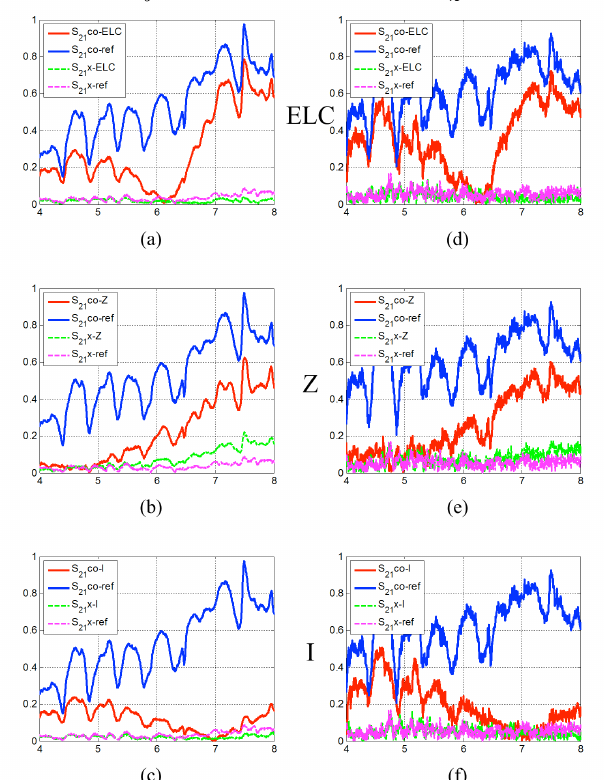
Figure 6: Comparison of cross-polarization measurements for the various ELC, Z-shaped and I-shaped designs. (a)-(c) 0° incidence. (d)-(f) 45° oblique incidence. For calibration, horns aligned and cross-polarization transmission measurements are shown for no sample present (blue and magenta